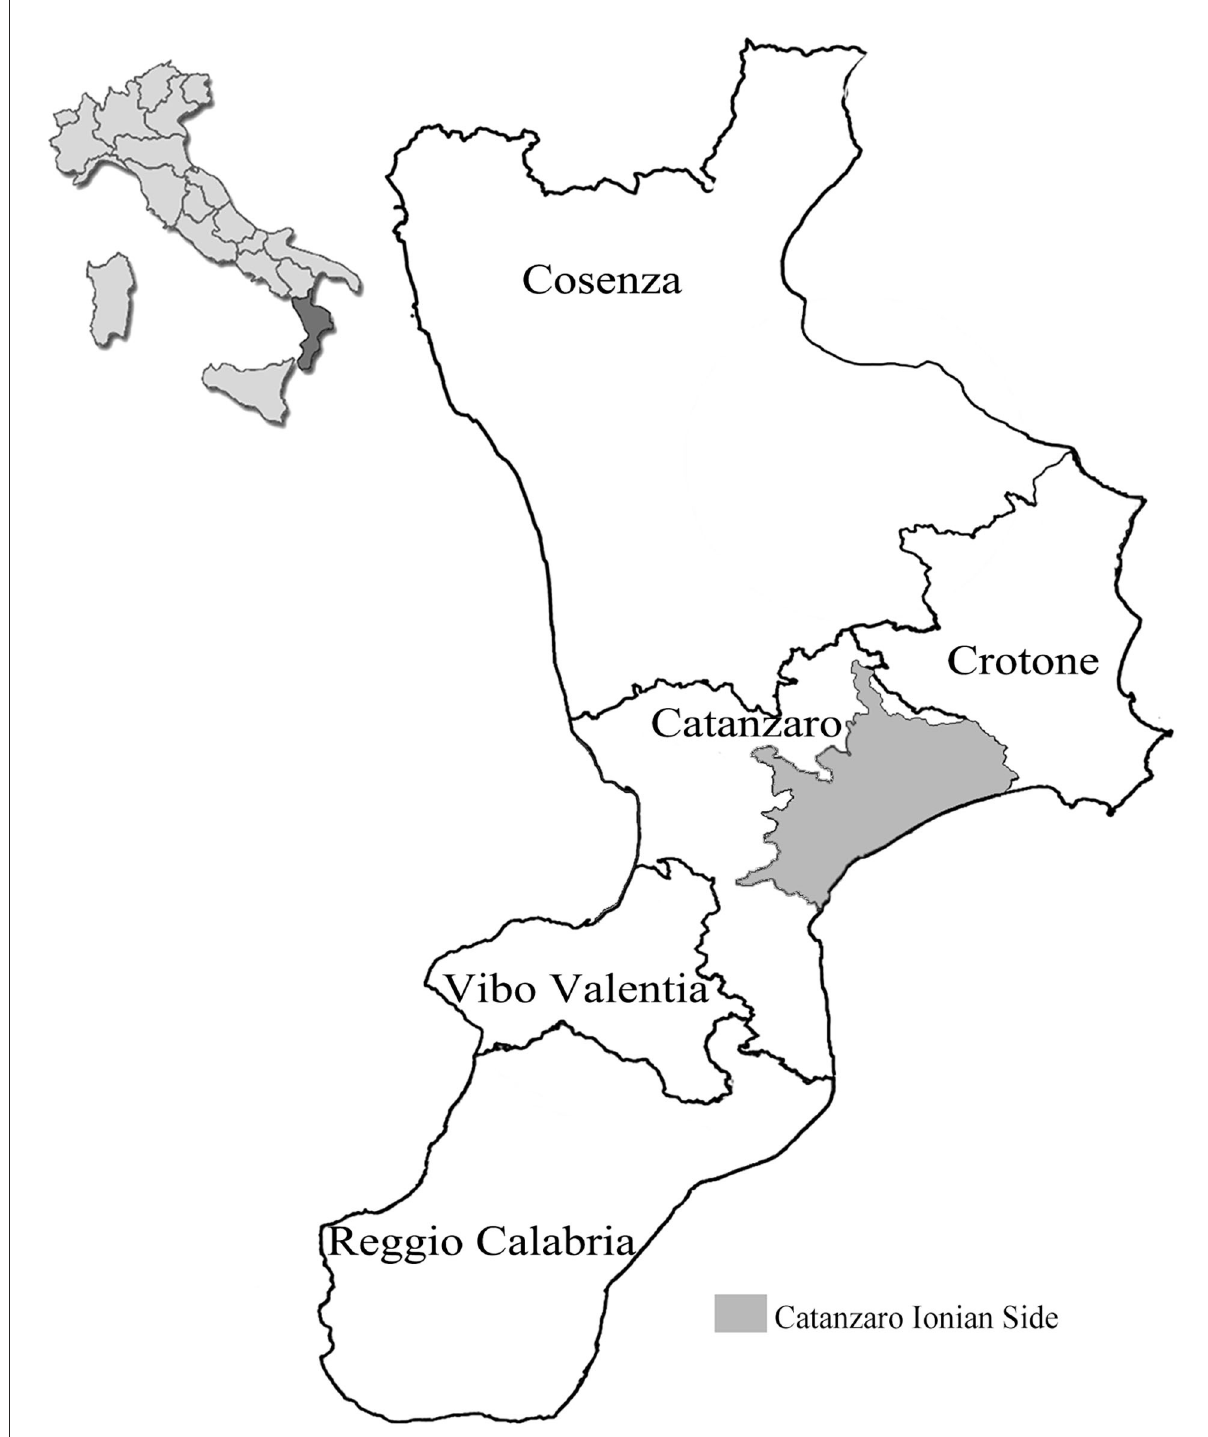
FIGURE2 Study area in Calabria region (Southern